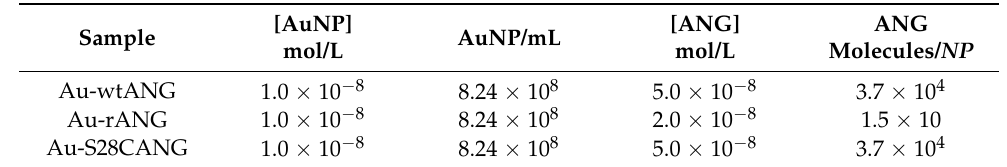
Table 2. Calculated concentrations (in mol/L and NP /mL) of AuNPs and number and number of ANG molecules per NP used for the functionalization